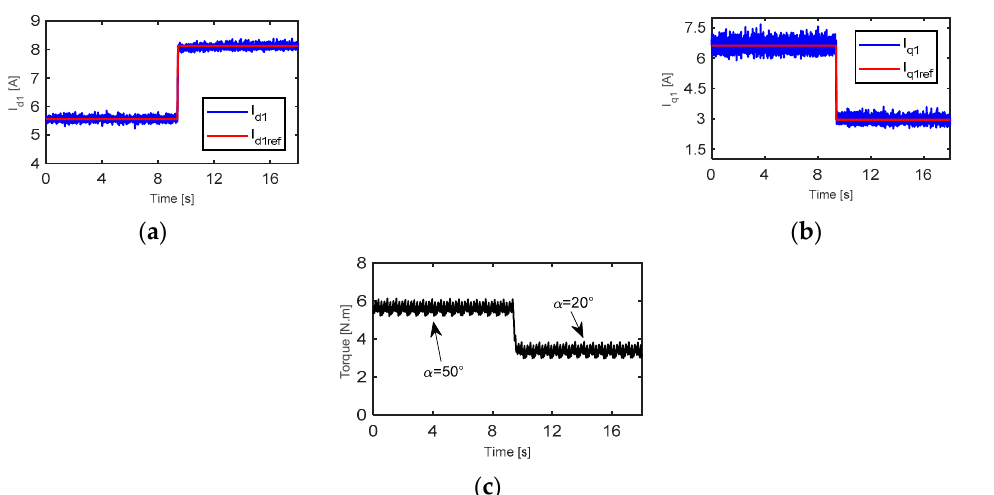
Figure 17. Dynamic performance of drive system at 8.65 A with current angle changes from 50° to 20°; ( a ) fundamental d-axis current, ( b ) fundamental q-axis current, and ( c ) the time response of the output torque.